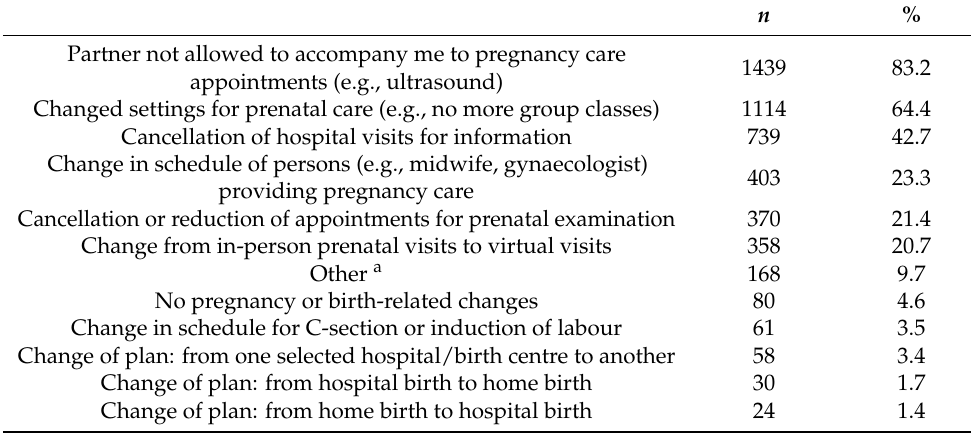
Table 2. Pregnancy and birth-related changes during the third wave of the COVID-19 pandemic.